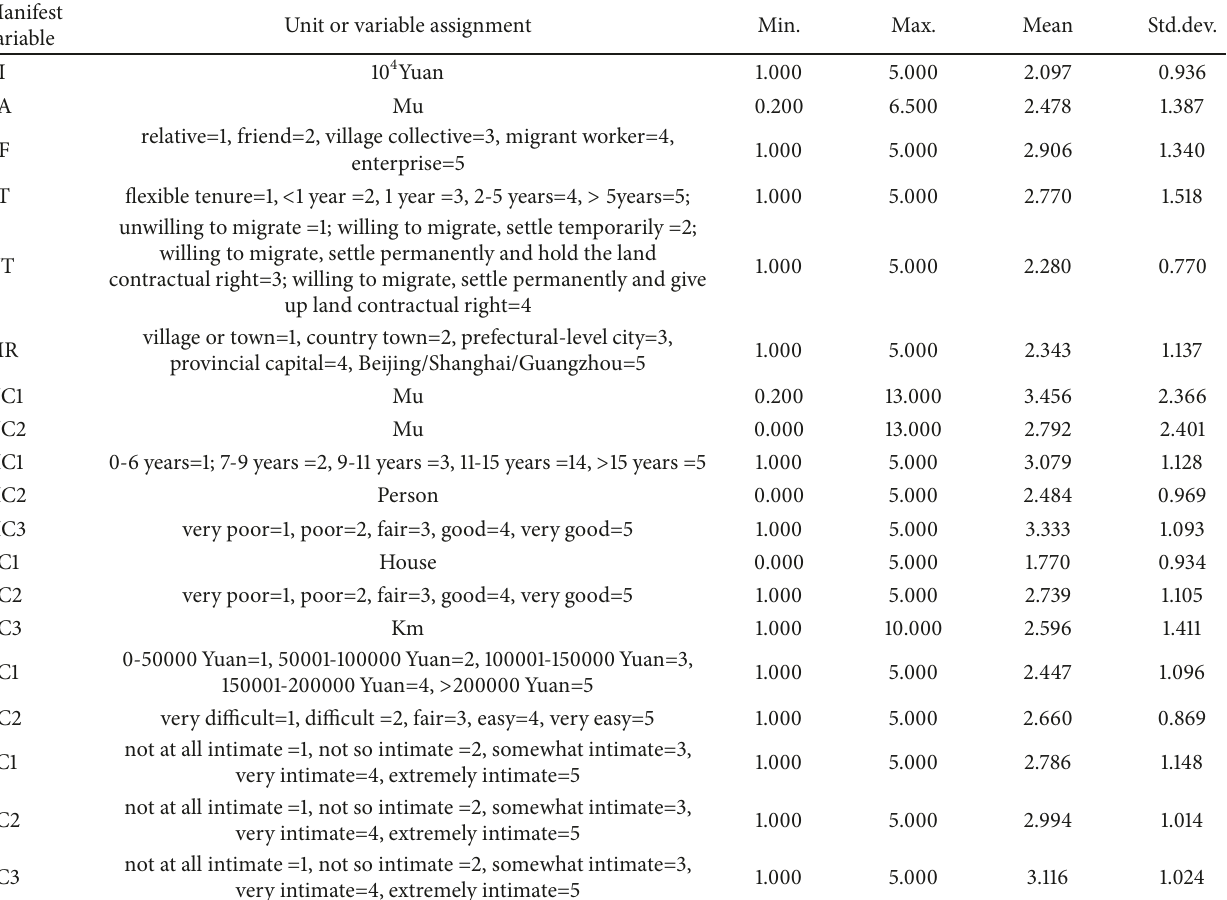
Table 2: Statistical description of manifest variables.